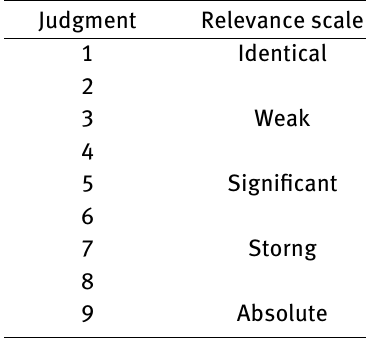
Table 2: Saaty‘s scale [25]